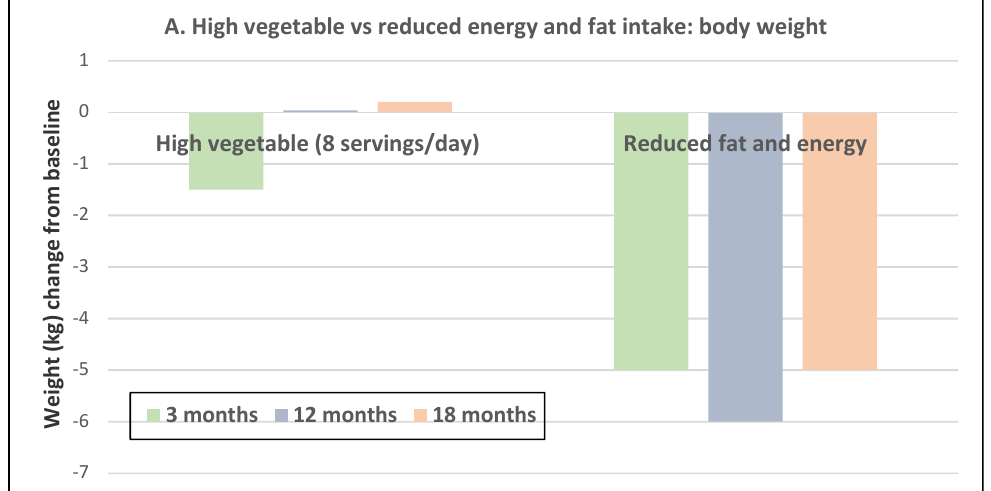
Figure 12. Change in weight and waist circumference in 75 obese women (mean age 37 years) consuming diets rich in fruit and vegetable (FV), whole grains, or a combination of both [45]. * Diets were a mean of 2100 kcals, and all diets contained ≥35 g fiber: 70% fiber from FV or cereals and 50/50% from each in the combination diet.